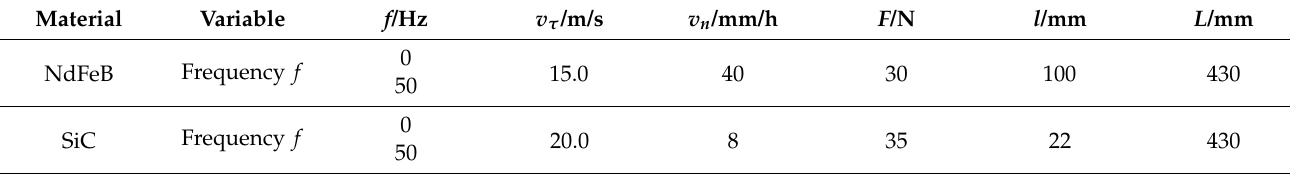
Table 4. Experimental design of vibration-assisted multi-wire